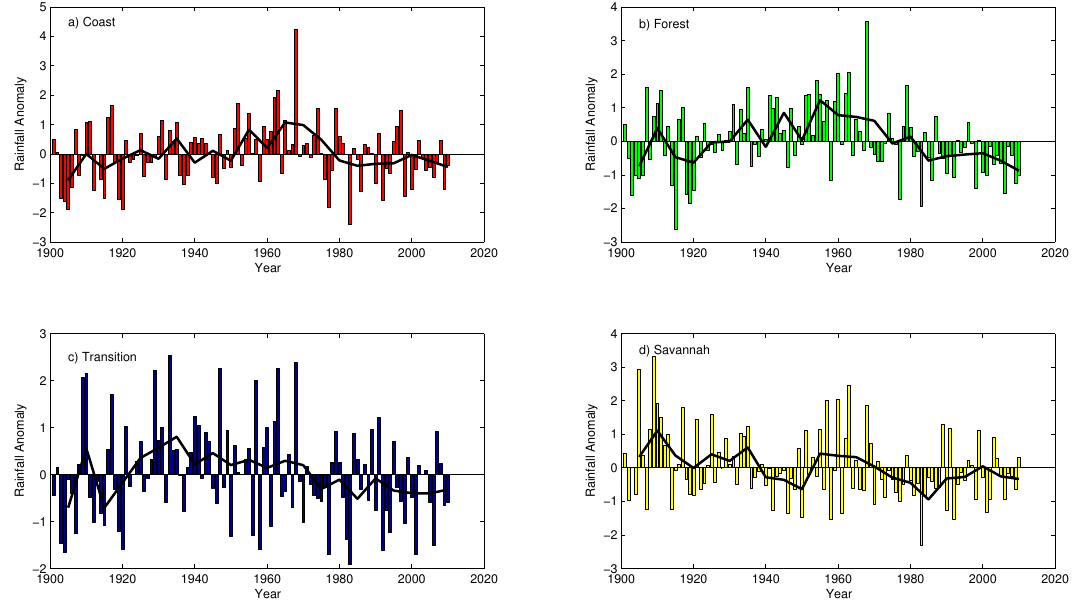
Figure 8. ( a – d ) Annual rainfall anomaly (bar) with a five year moving average (line) for the agro-ecological zones of Ghana from